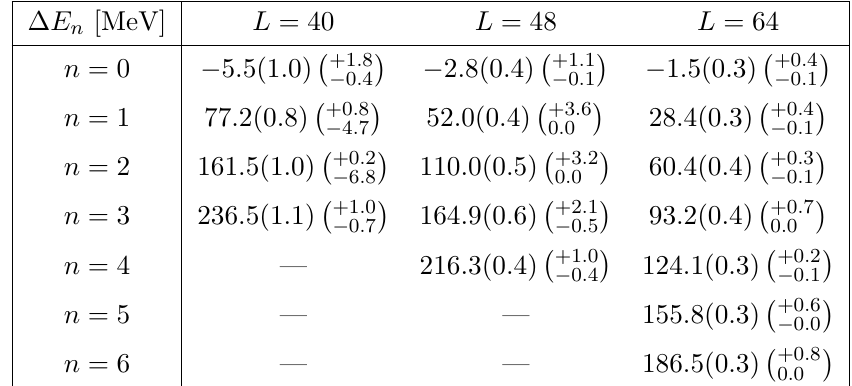
Table 2 . Eigenvalues of the n -th eigenfunction below the inelastic threshold in the A + tation of the HAL QCD Hamiltonian H LO in each volume. Eigenvalues are given in terms of the energy shifts from the threshold, (cid:1) E n (cid:17) W n (cid:0) 2 m (cid:4) . Central values and statistical errors are evalu- ated at t=a = 13, while the systematic errors are estimated by using the results at t=a = 14 ; 15 ;